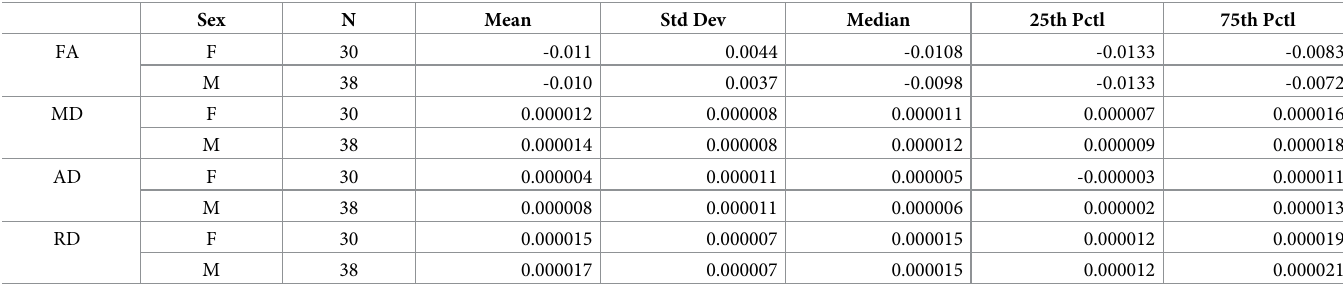
Table 2. Sex differences in changes in DTI metrics between baseline and 40 minutes after induction of